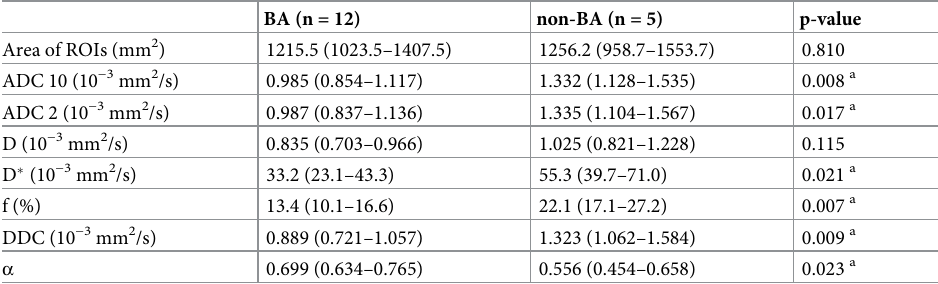
Table 2. Comparison of MRI parameters between BA and non-BA groups.